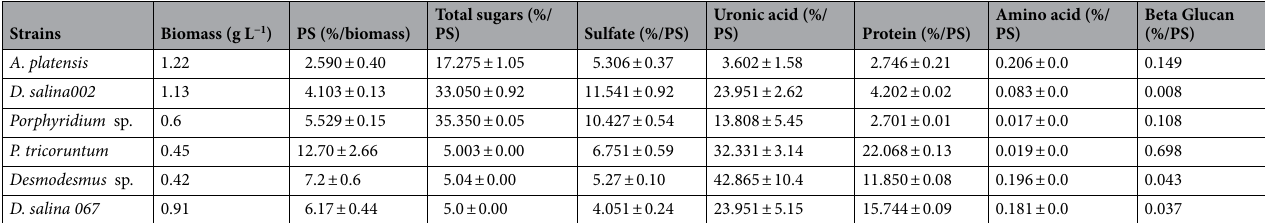
Table 1. Biomass production and composition of polysaccharides extracted from Moroccan